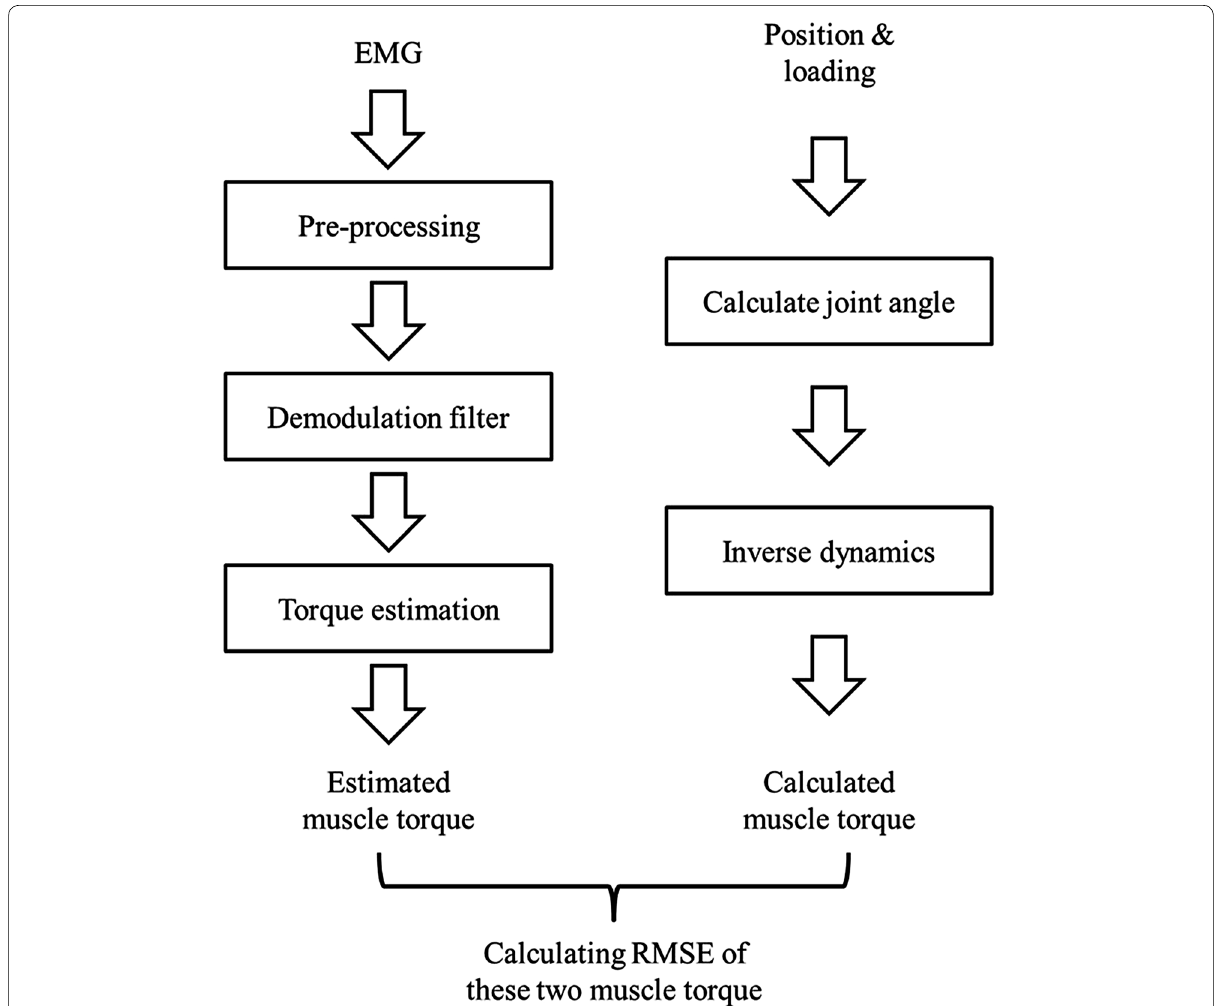
Fig. 10 Flow to evaluate the proposed demodulation algorithm